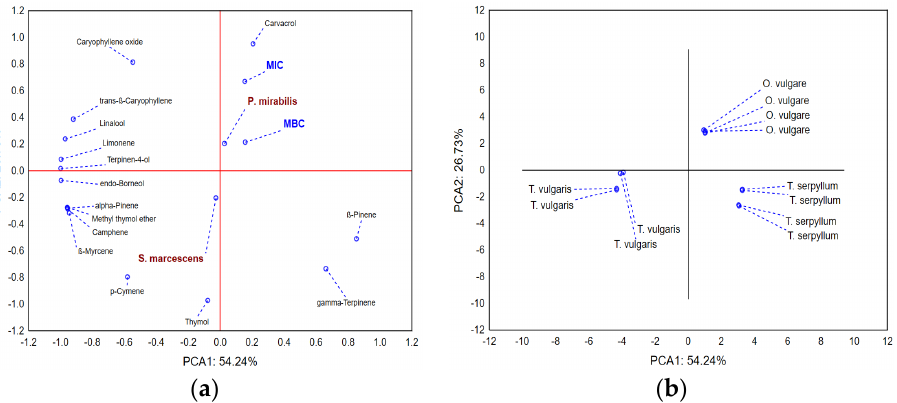
Figure 3. Antimicrobial potential and chemical profiles of the essential oils—compounds. PCA loadings ( a ) and positions of the evaluated samples in the space defined by the first two principal components’ axes ( b ).